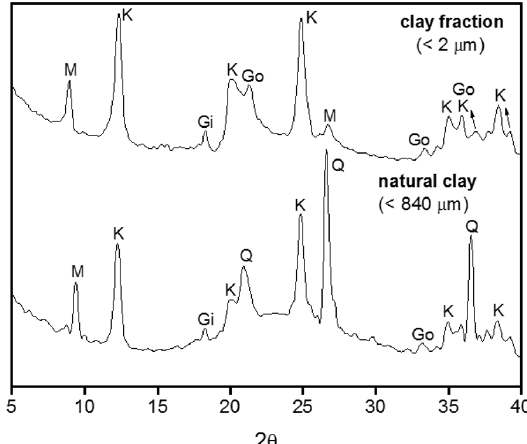
Figure 2. XRD patterns of the clay fraction and the natural clay. Gi = gibbsite; Go = goethite; K = kaolinite; M = micaceous mineral; Q = quartz.